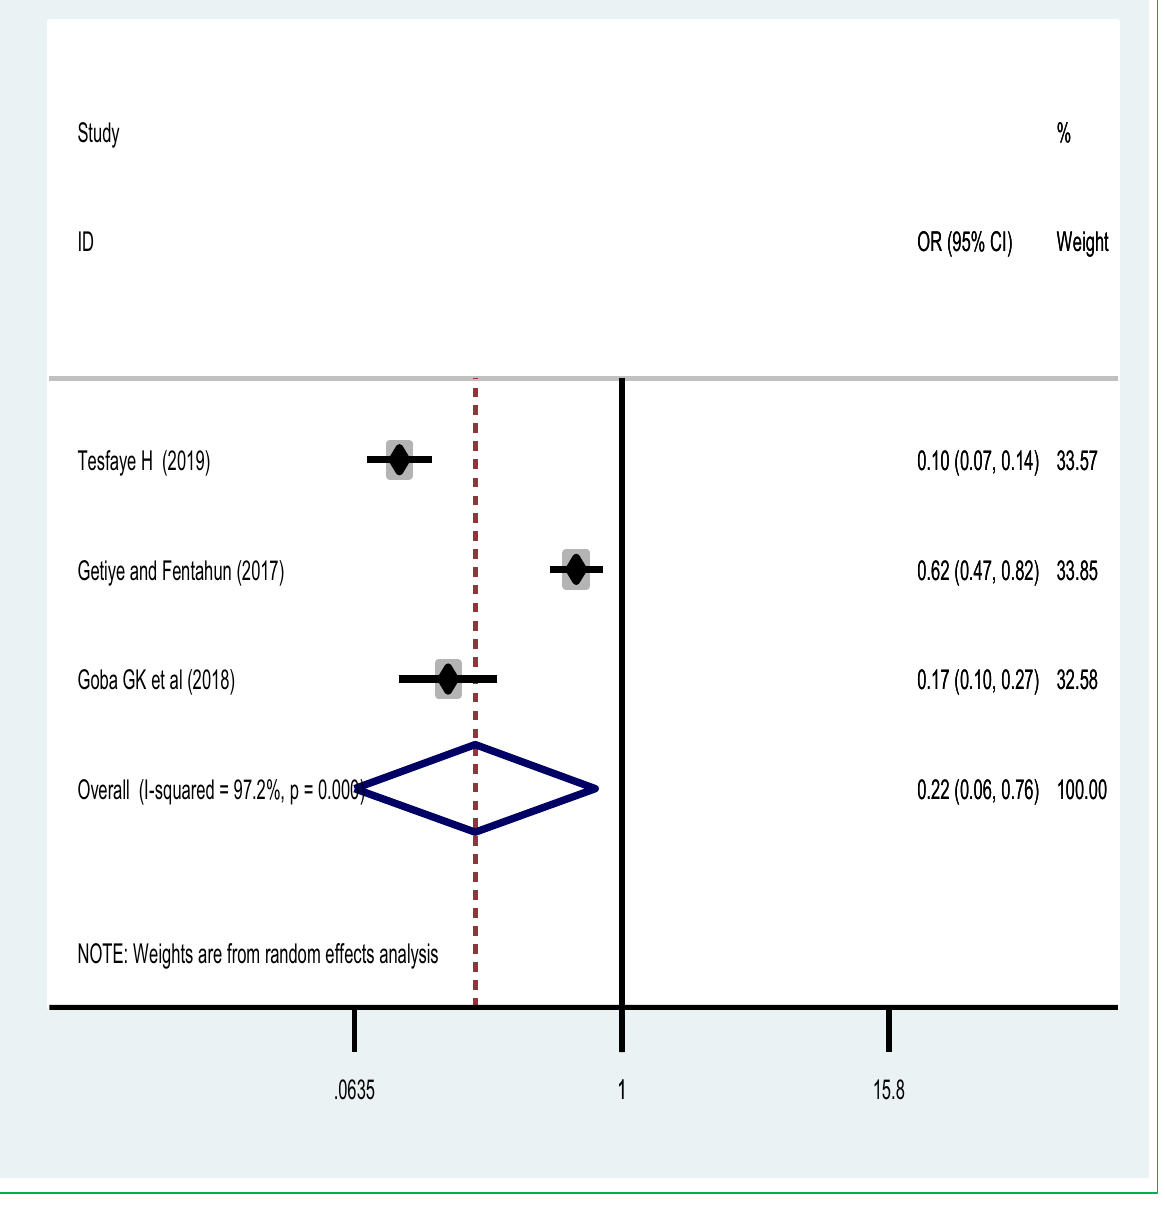
Figure 7. Association of impact of partograph utilization and perinatal